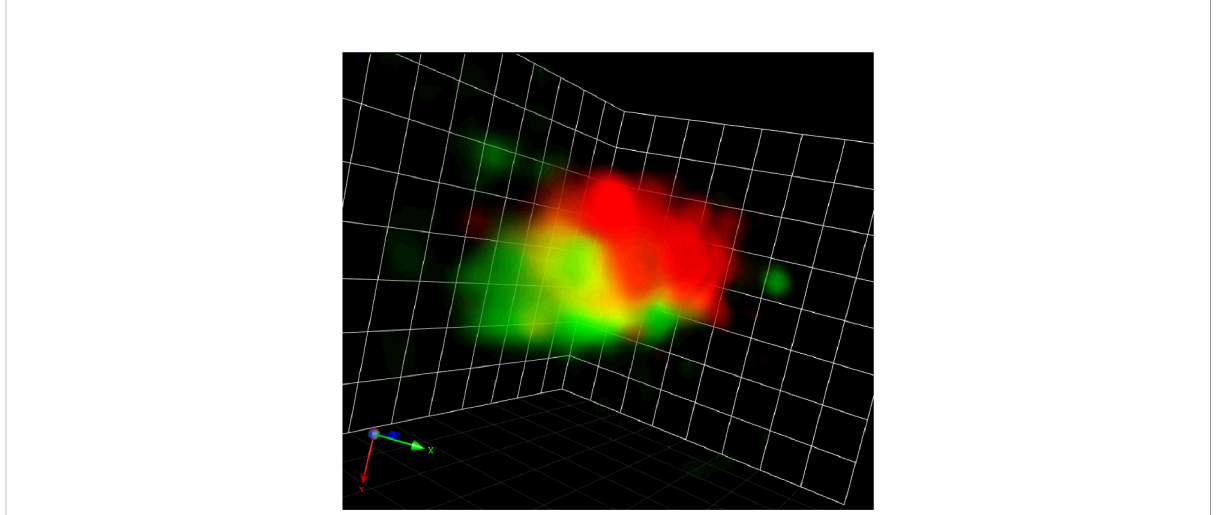
FIGURE 2 A Golgi stack visualized by SCLIM-2M. A snapshot of a 3D movie of a Golgi stack visualized by GFP-SYP31 ( cis ) and ST-mRFP (medial/ trans ) in a tobacco BY-2 cell captured by SCLIM-2M. Grid = 441